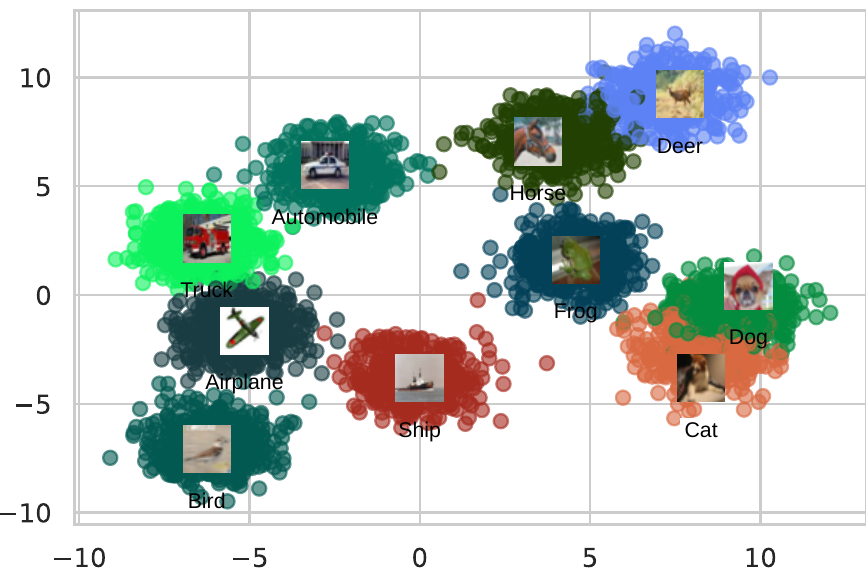
Figure 8. The figure illustrates a scatter plot of the embedding space generated on CIFAR-10 dataset.